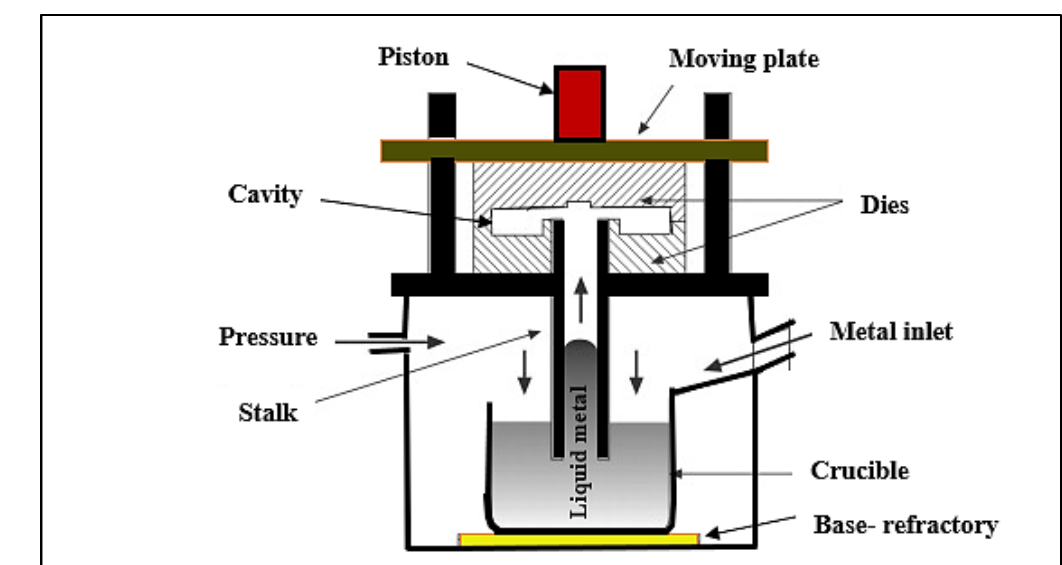
Figure 1. Schematic of the die-casting process.